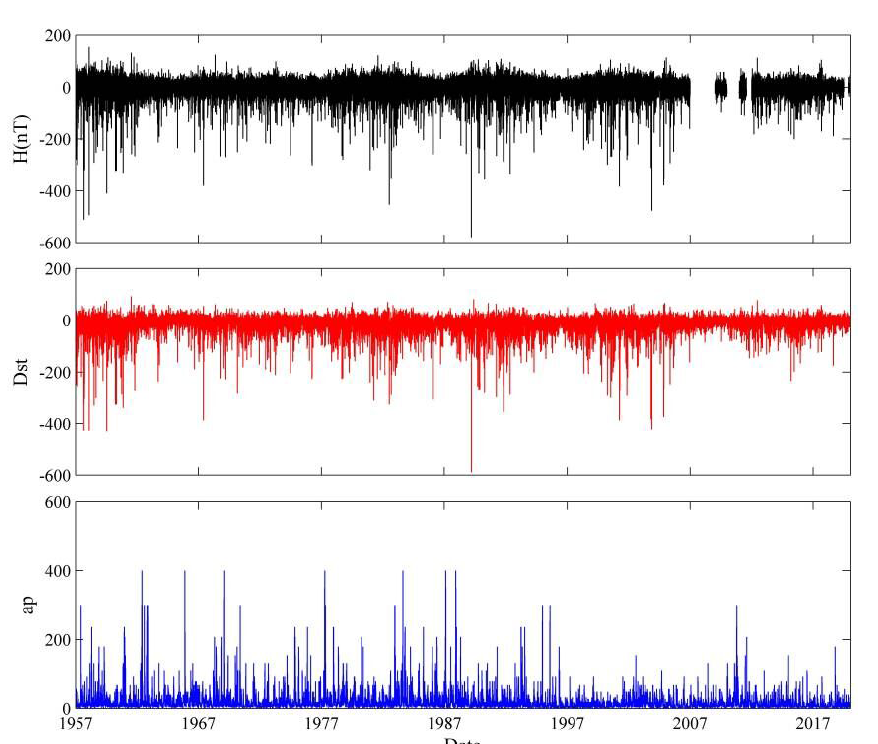
Figure 9. Comparative analysis of the H components with Dst and ap indices.